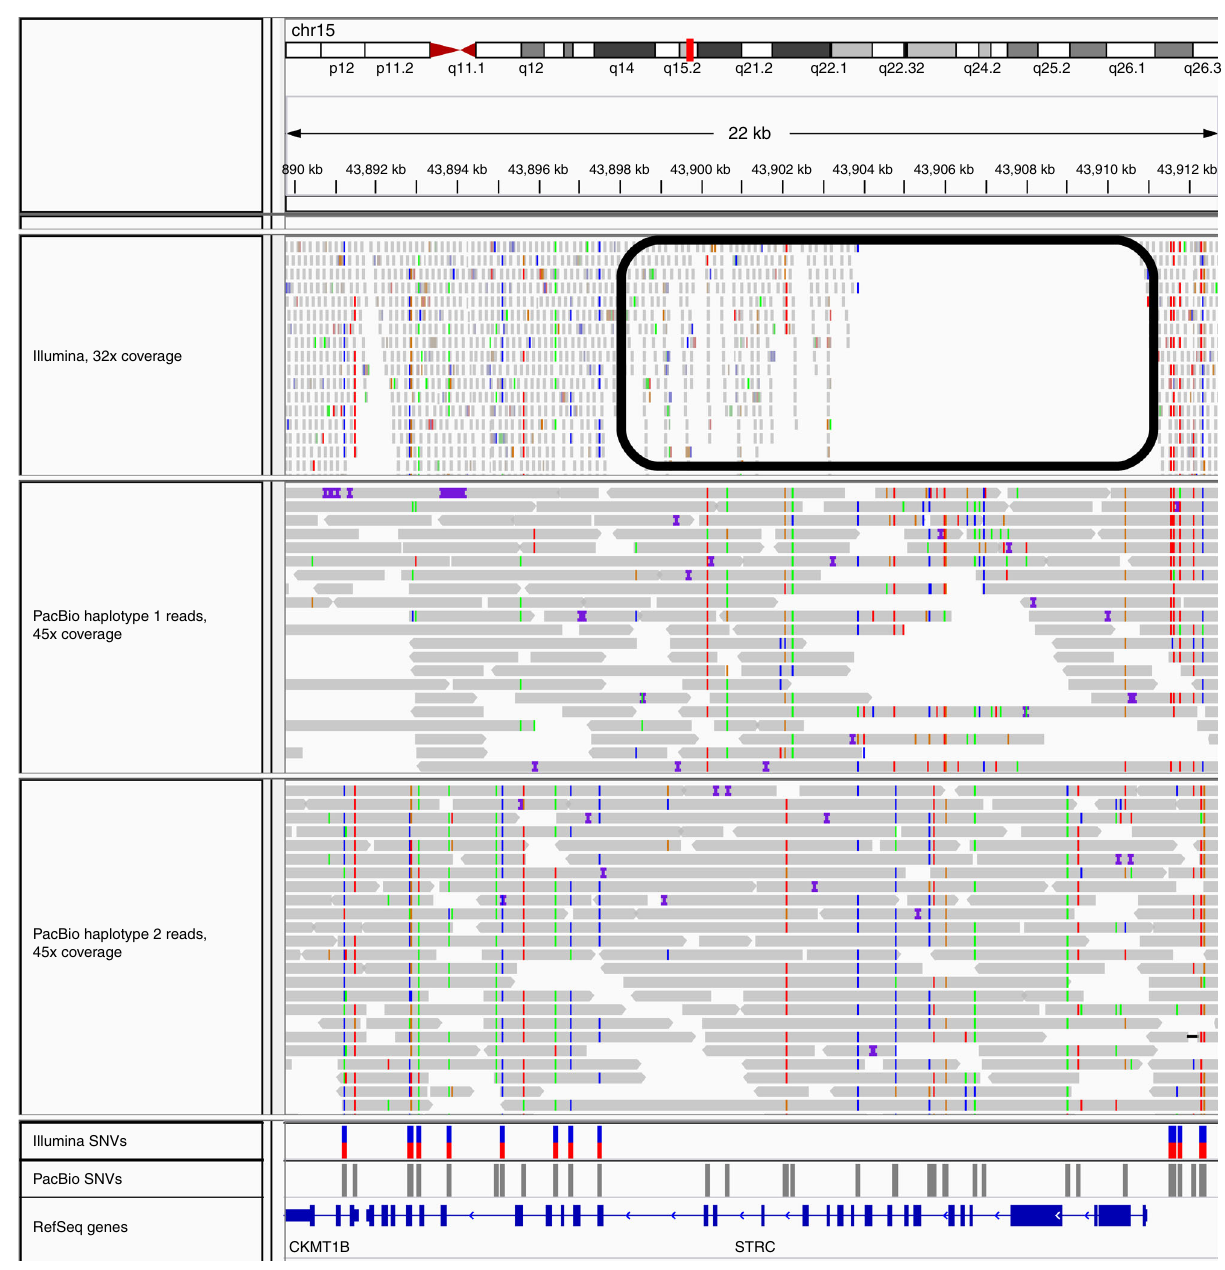
Fig. 3 Accurate variant calling using SMS reads and Longshot in the duplicated gene STRC . An Integrated Genomics Viewer (IGV) view of mapped reads shows that a long segment of the gene (circled in black) has low coverage using uniquely mapped Illumina reads due to the presence of a long segmental duplication with high sequence similarity ( > 99 : 8 % ) that spans the entire gene. PacBio reads (separated by haplotype using Longshot phased SNVs) have consistent coverage of mapped reads across the entire gene, allowing Longshot to call 42 SNVs of which 20 are shared with short reads, and 22 are unique to